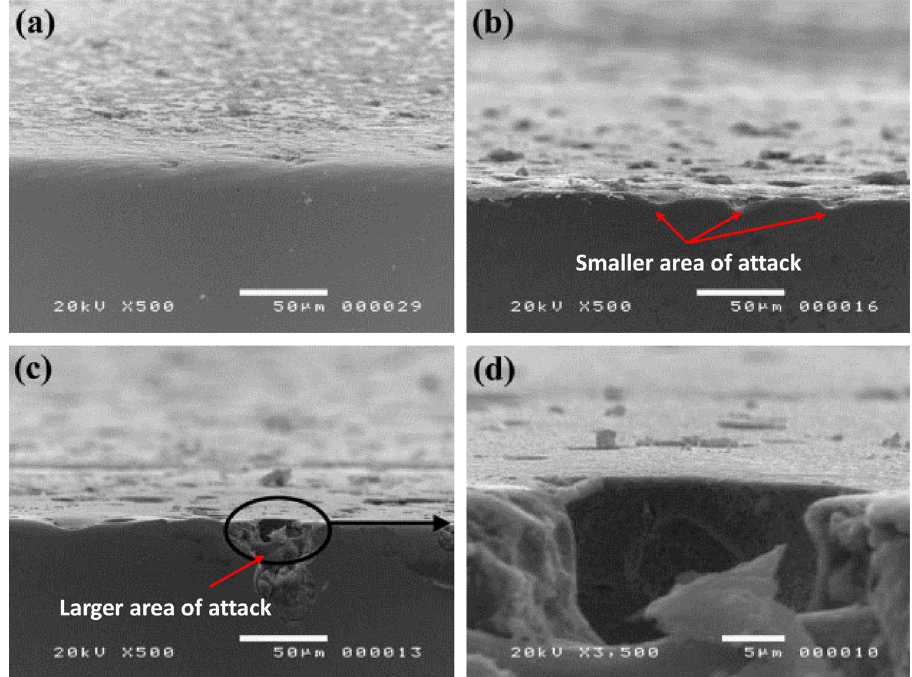
Fig. 3 The SEM micrographs for the Al x CrFe 1.5 MnNi 0.5 alloys with different molar concentrations of Al, after the anodic polarisation exceeded the breakdown potential ( > 1.25 V SHE ) in 0.5 M H 2 SO 4 a x = 0, b x = 0.3 mol, c x = 0.5 mol, d a higher magni fi cation image of the inset